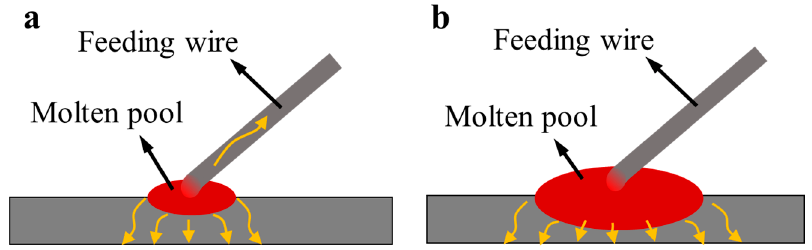
Figure 8. Schematic of heat dissipation at ( a ) small width of molten pool (WMP) and ( b ) large WMP.